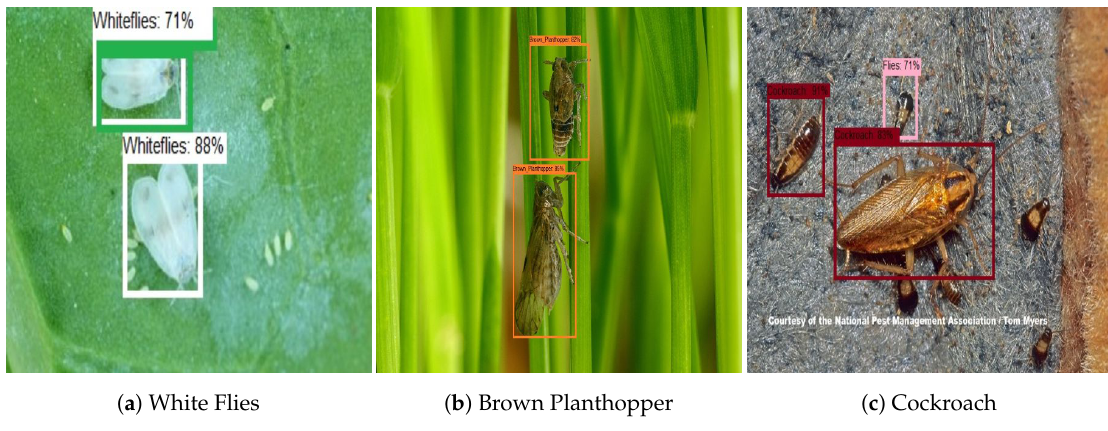
Figure 9. SSD MobileNet insect identification results.